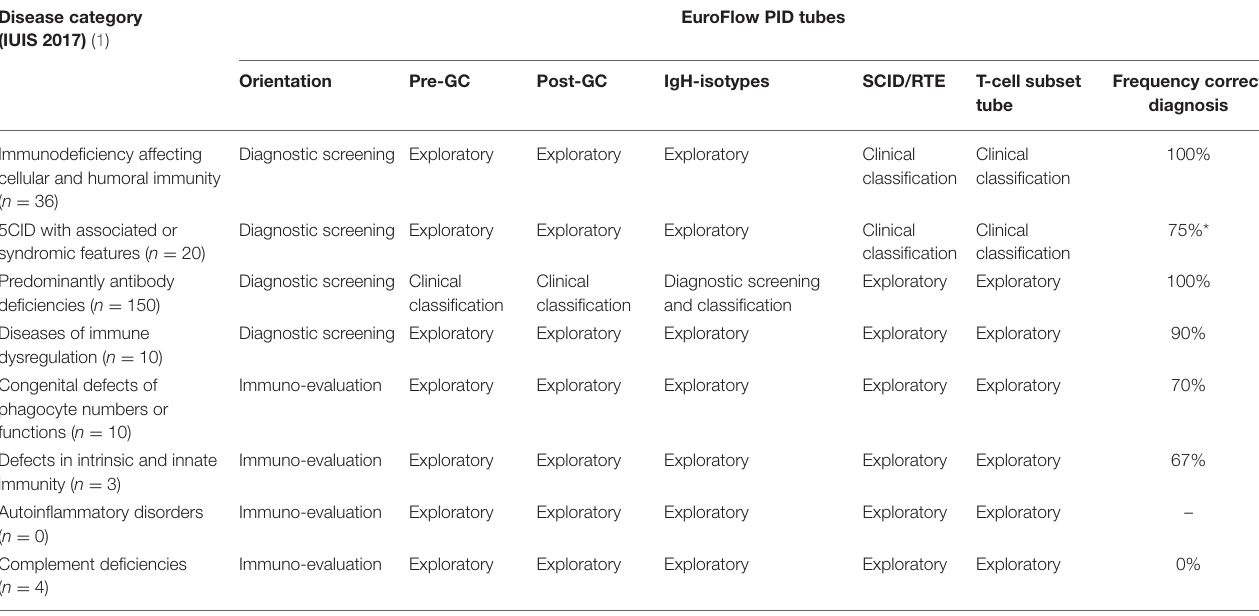
TABLE 5 | Application of EuroFlow PID tubes for the primary immunodeficiency disease categories. Disease category (IUIS 2017) (1)